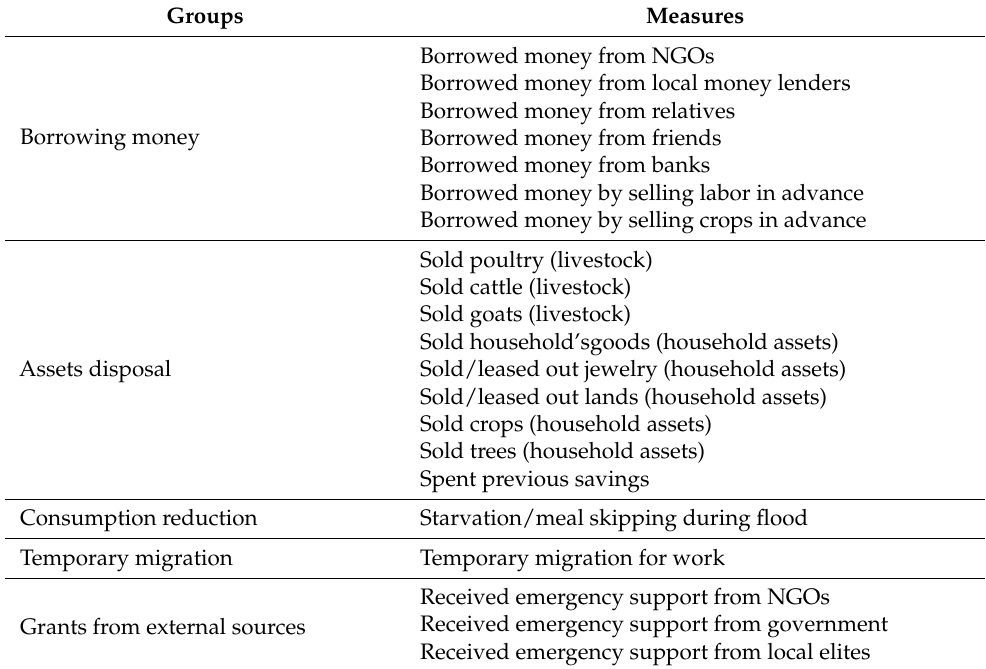
Table A1. Coping Strategies Included in the